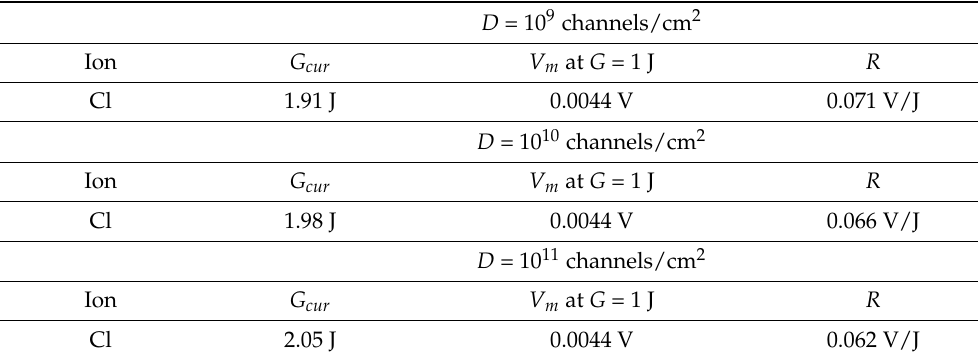
Table 3. The table represents the curving energy point, the membrane potential at G = 1 J, and the average rate of depolarization at different values of channels density D and according to the other setting values in Figure